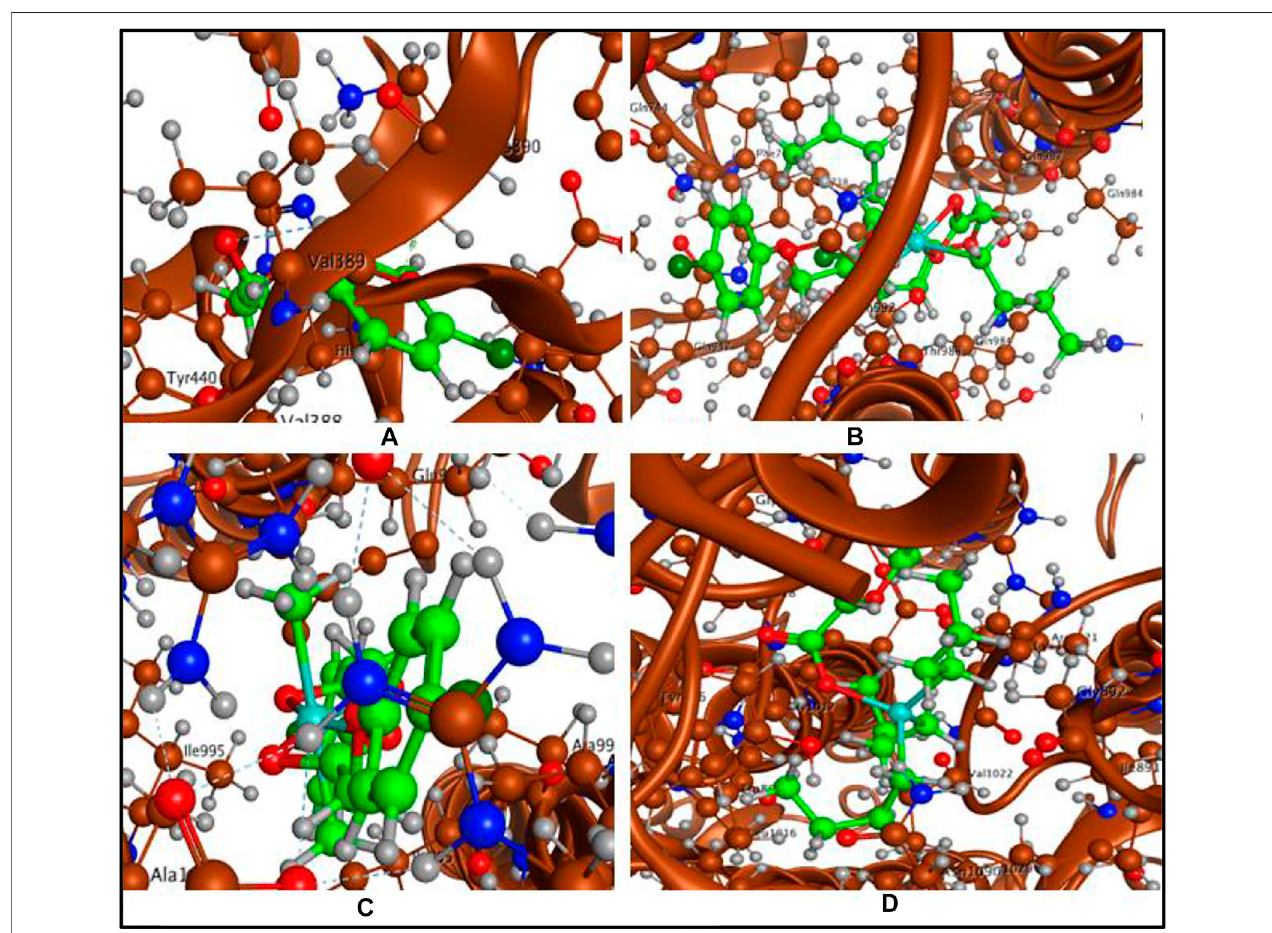
FIGURE 8 | (A) Ligand acid ( HL )-spike protein interaction, (B) Complex 1 -spike protein interaction, (C) Complex 2 -spike protein interaction and (D) Complex 3 - spike protein